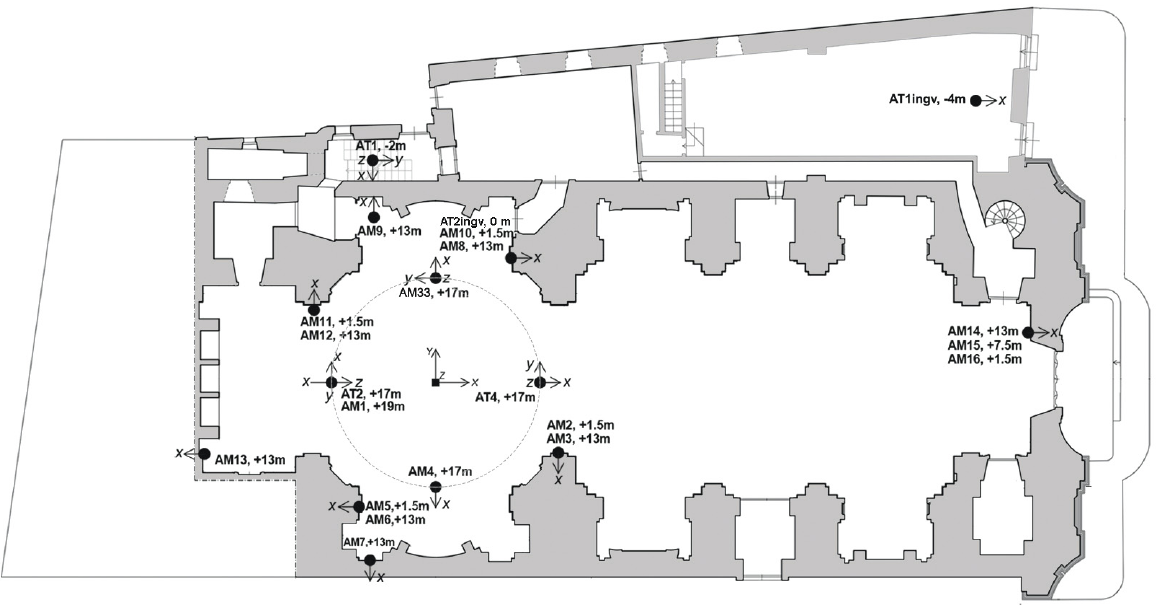
Figure 3. Plan scheme of the accelerometers and velocimeters installed into the church. The longitudinal axis of the church is oriented ap- proximately in a N+20 degree direction (clockwise) with respect to the geographic